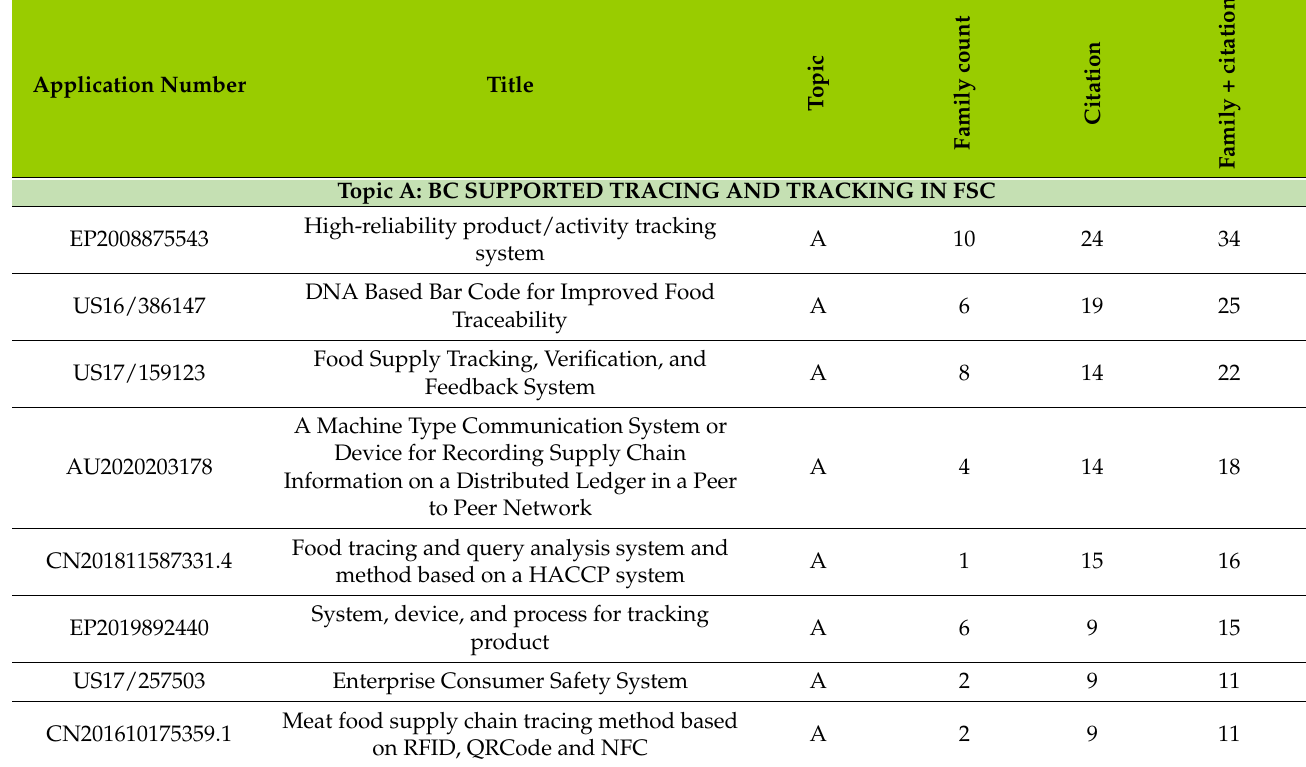
Table 3. The 16 potentially most influential patents from the observed patent portfolio by identified